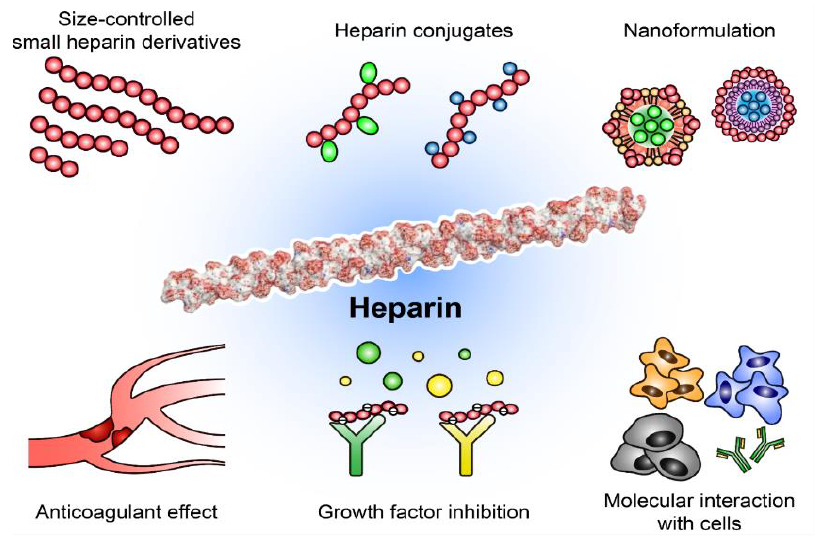
Figure 1. Schematic illustration of heparin derivatives and applications. Various derivatives have increased the variety of therapeutic uses available, which can serve not only as anticoagulants, but also as functional biomolecules for diverse